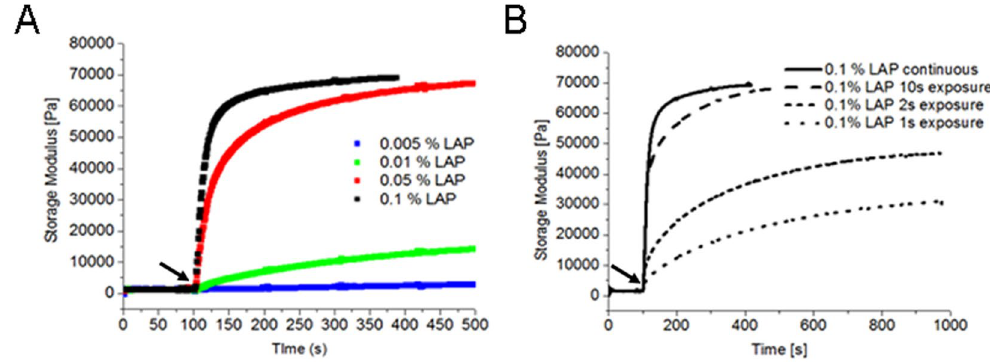
Figure 2. Higher concentration of LAP photoinitiator favour higher storage modulus. In situ photo-rheometry of GelMa/HAMa hydrogels incorporating LAP during the crosslinking reaction. Each plot shows storage modulus as a function of time with the UV light (365 nm, 100 mW/cm2) switched on at 100 s. ( A ) Storage modulus as a function of continuous UV exposure time for four concentrations of LAP (0.005% = open squares, 0.01% = light grey squares, 0.05% = grey squares and 0.1% = black squares). Both the reaction rate and the final storage modulus are impacted by LAP concentration. Low concentrations produce slow reactions resulting in low modulus hydrogels. The two highest LAP concentrations (0.05% and 0.1%) achieve comparable final modulus (~70 kPa), although the 0.05% concentration requires much longer exposure time to achieve this. ( B ) Effect of dark polymerization. GelMa/HAMa hydrogels incorporating 0.1% LAP were exposed to continuous UV exposure (thick black line) or single bursts of short times (10 s, 2 s and 1 s). The arrows indicate the point at which the UV light was switched off for the continuous exposure (100 s). During light exposure, all hydrogels follow similar crosslinking kinetics, however after the light turns off dark polymerization can continue for many minutes. In the case of the 10 s exposed hydrogel, the dark polymerization is sufficient to match the material crosslinked with a (much longer) continuous exposure.